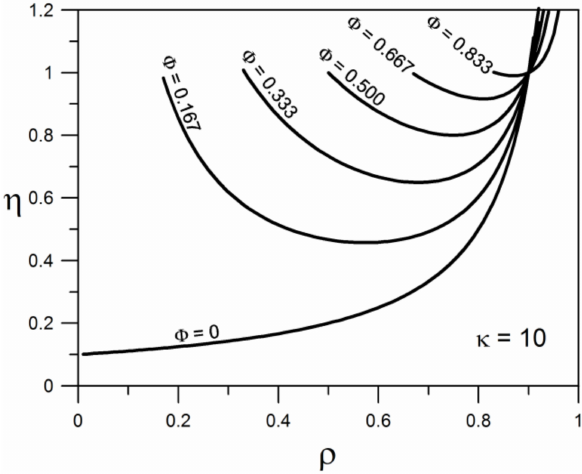
Figure 11. Relationship η = F 2 ( ρ , Φ